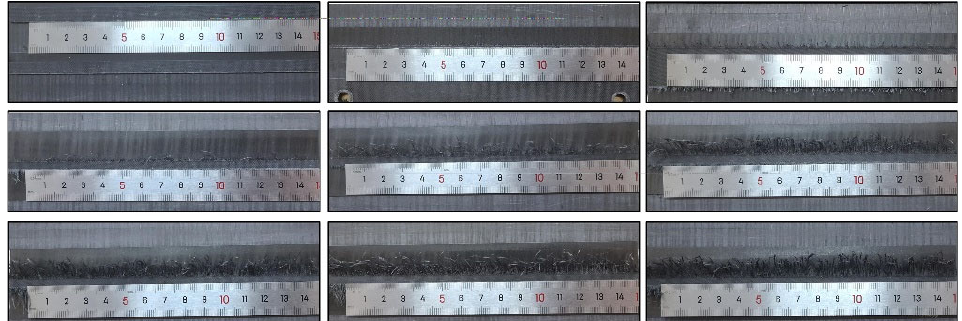
Figure 4. Burrs length at different cutting lengths.